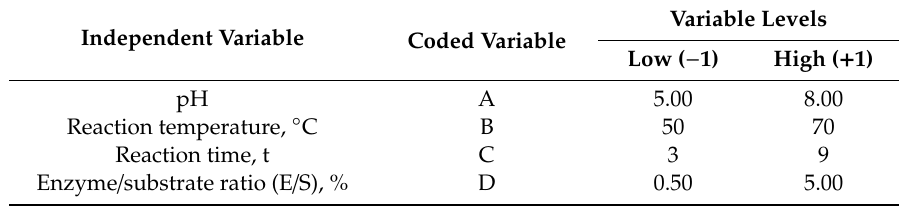
Table 1. Experimental ranges and independent variables used in enzymatic hydrolysis